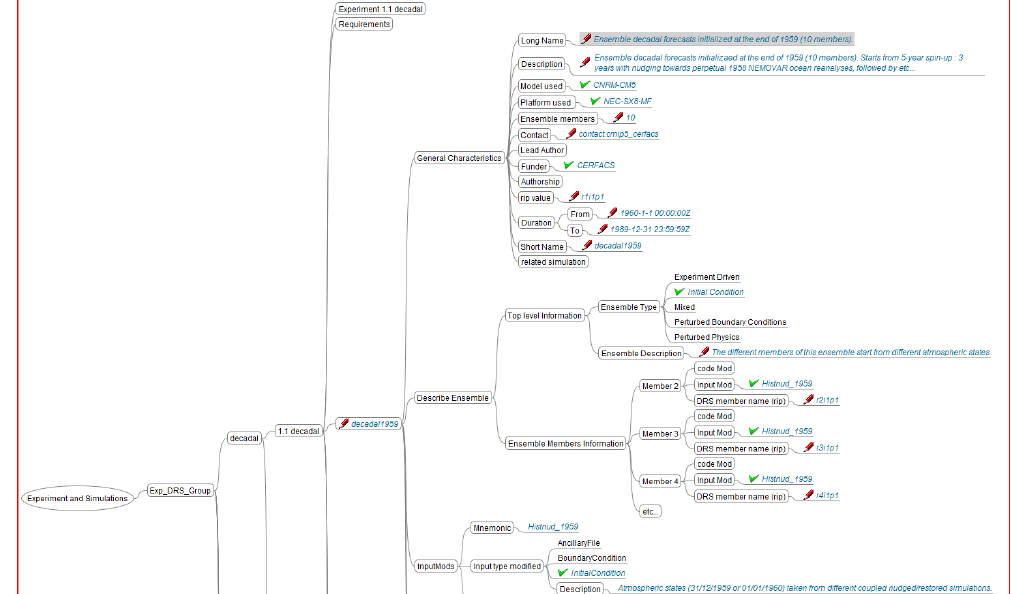
Fig. 5. Tree diagram showing attributes used to describe an ensemble simulation. Reproduced here is what the CERFACS group filled in (blue text with a red pencil icon) or what it selected (blue text with a green tick mark icon) through the CMIP5 Questionnaire interface (see Sect. 5). What can be deduced from the information given is that the simulation labelled decadal1959 realizes a 1.1 decadal experiment using the CNRM-CM5 model and was run on NEC-SX8-MF platform. The simulation duration is 30years (from beginning of 1960 till the end of 1989). The ensemble is made of 10 members, each being identified by a unique rip value ; rip of the first member is used as the identifier of the ensemble. Members can be distinguished by their initial condition. Histnud_1959 is a mnemonic that refers to an Input modification the users has previously registered. It provides details about the difference between members of the ensemble (here different initial atmospheric states). Notice that this tree diagram is just illustrative (it is not a CV mindmap).